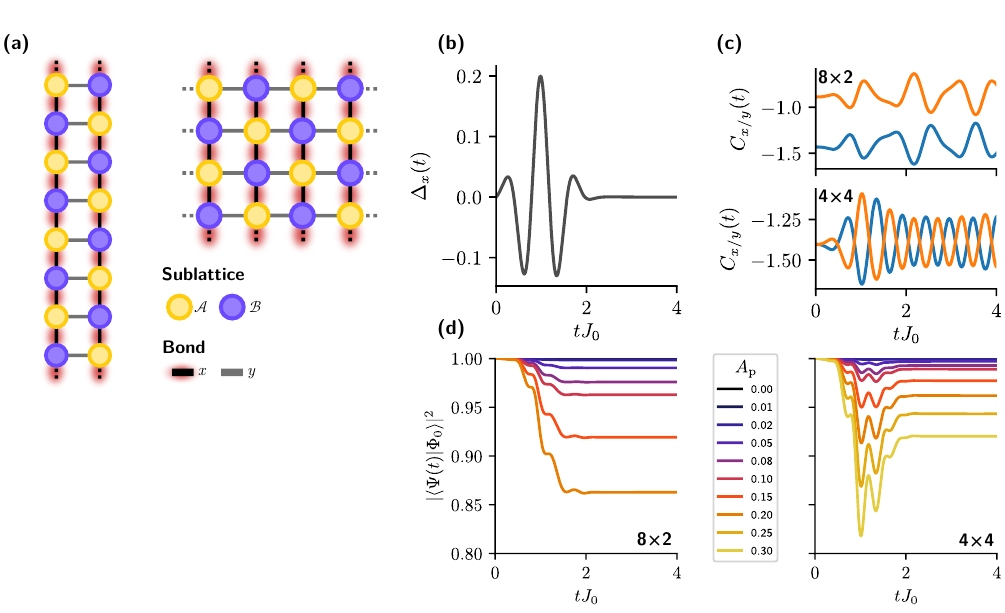
Figure 1: (a) Ladder and square lattice geometry for the 2D AFM Heisenberg model. The colors indicate the and sublattices of the bipartite model. In the ladder A B geometry, periodic boundary conditions (PBC) in the x direction are imposed. In the square geometry, PBC are imposed in both directions. (b) The Heisenberg system is driven out of its ground state by modulating the x -bond coupling in a single pulse ( t ) [ Eq. (3) ] , here displayed for A = 0.20, t = 0.987 J − 1 = 8.0 J with shape ∆ , ω , x p p p 0 0 = 0.4 J − 2 ( t ) and σ . (c) Oscillations of the x and y bond spin-spin correlations C x / y p 0 [ Eq. (4) ] caused by the pulse for both geometries as computed from the exact time- 〉 obtained from ED with the exact evolved state. (d) Overlap of the initial state | Φ 0 〉 for varying pulse amplitude A time-evolved state | Ψ ( t ) 〉 = ˆ U ( t ) | Φ and both ge- 0 p ometries. The other pulse parameters are the same as in panel